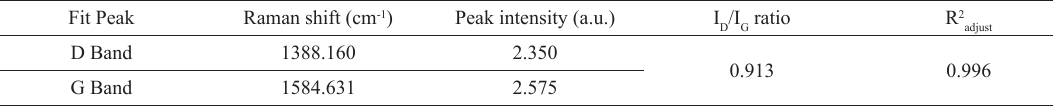
Table 3. Results from Raman spectrum deconvolution of DLC coating Fit Peak